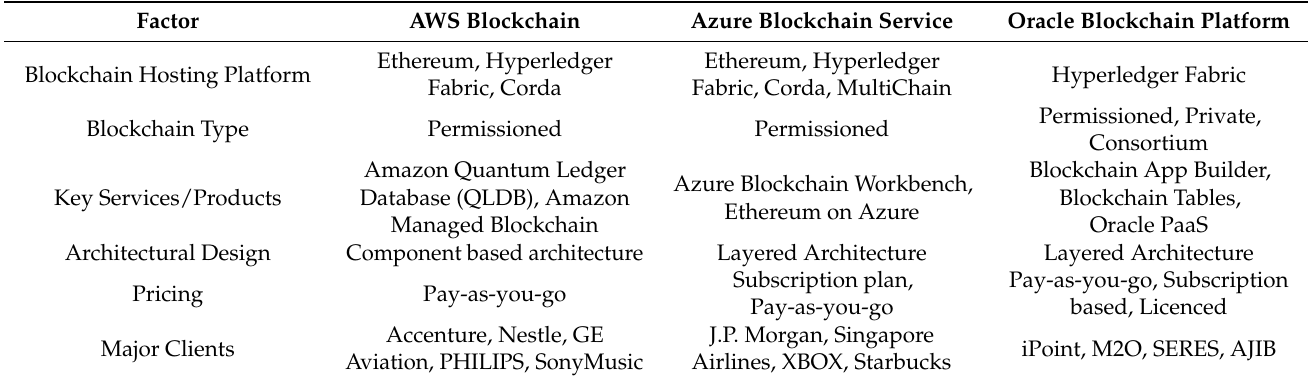
Table 4. Comparative analysis of blockchain services by Cloud